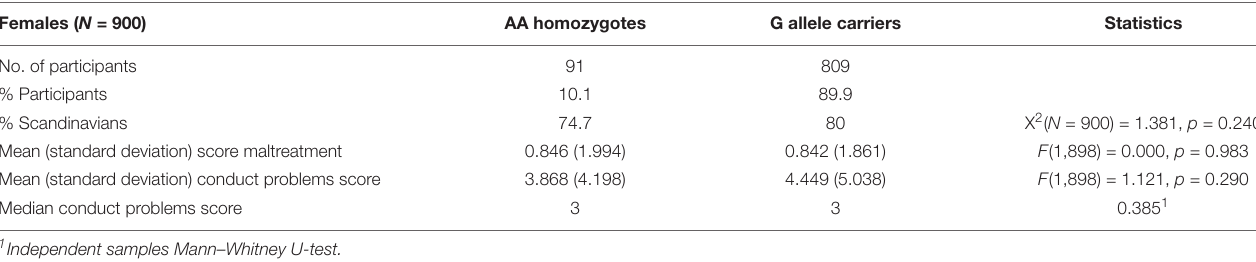
TABLE 2 | Comparisons of characteristics of AA homozygotes and G allele carriers among female participants.